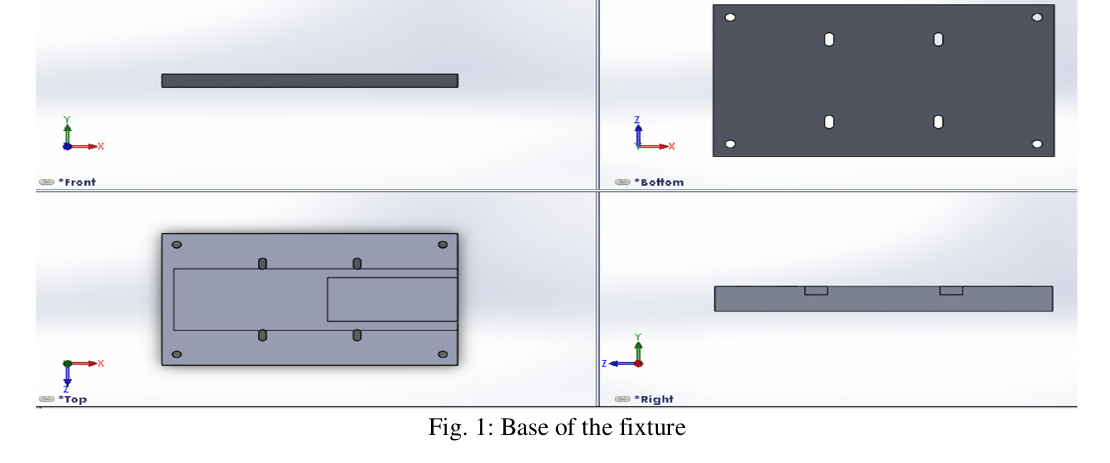
Fig. 1: Base of the fixture